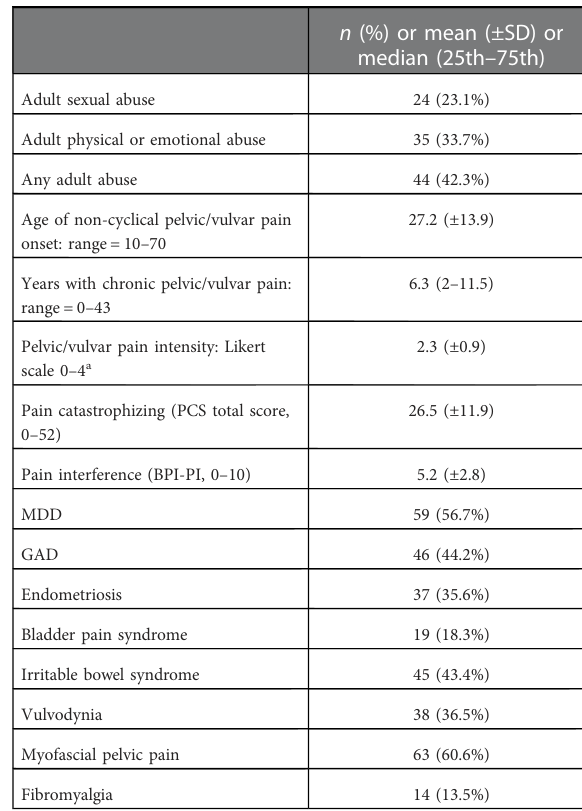
TABLE 1 Characteristics of the study sample ( n